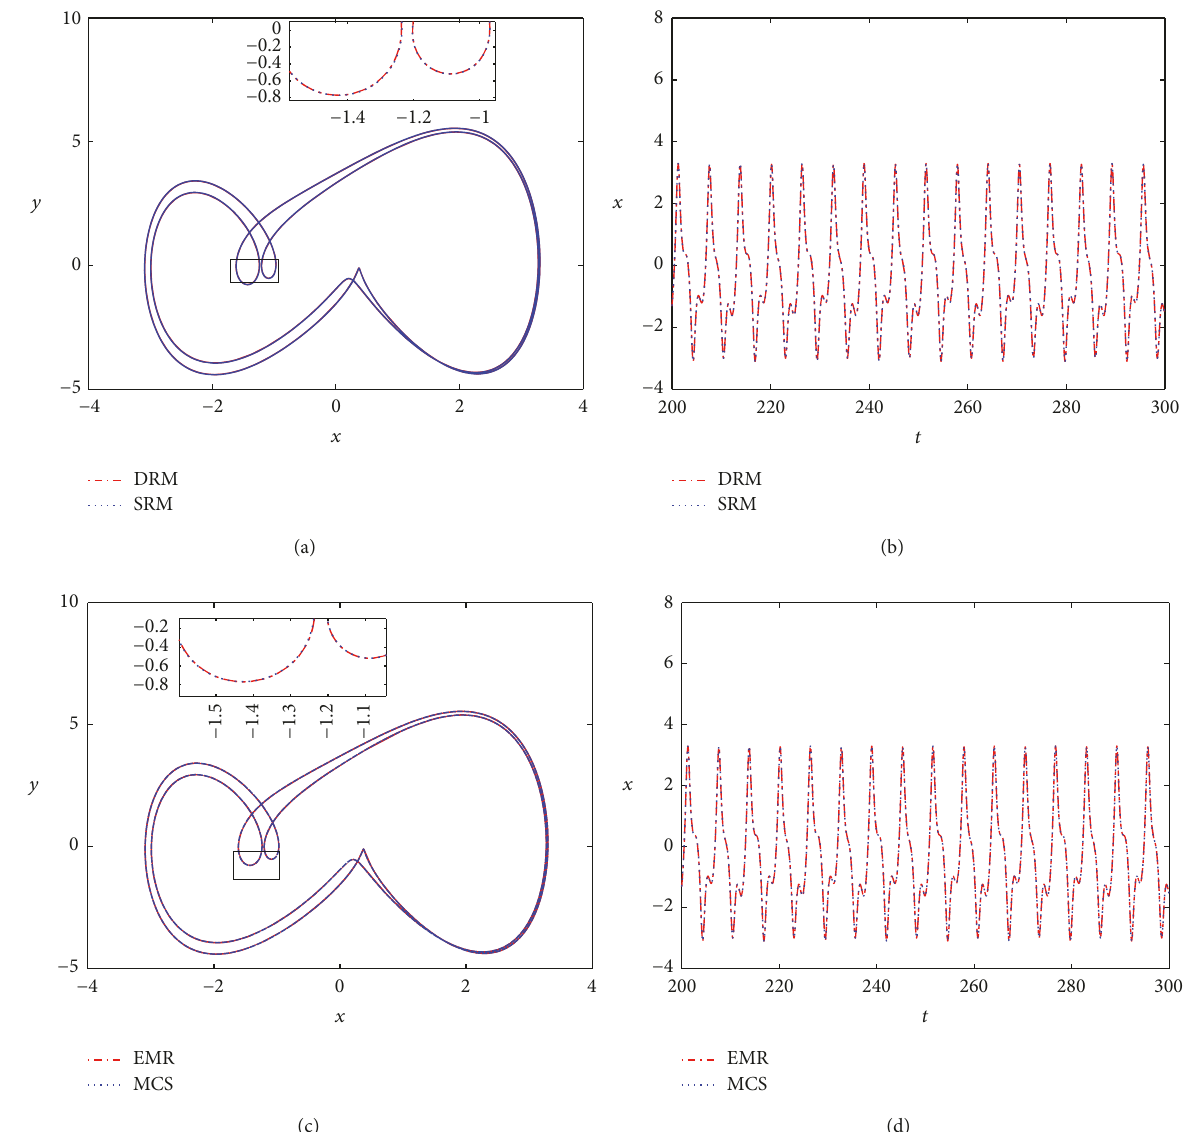
Figure 4: Period 2 𝑇 for 𝑞 = 0.988 : (a) phase portrait for DRM-SRM; (b) time history diagram for DRM-SRM; (c) phase portrait for EMR- MCS; (d) time history diagram for